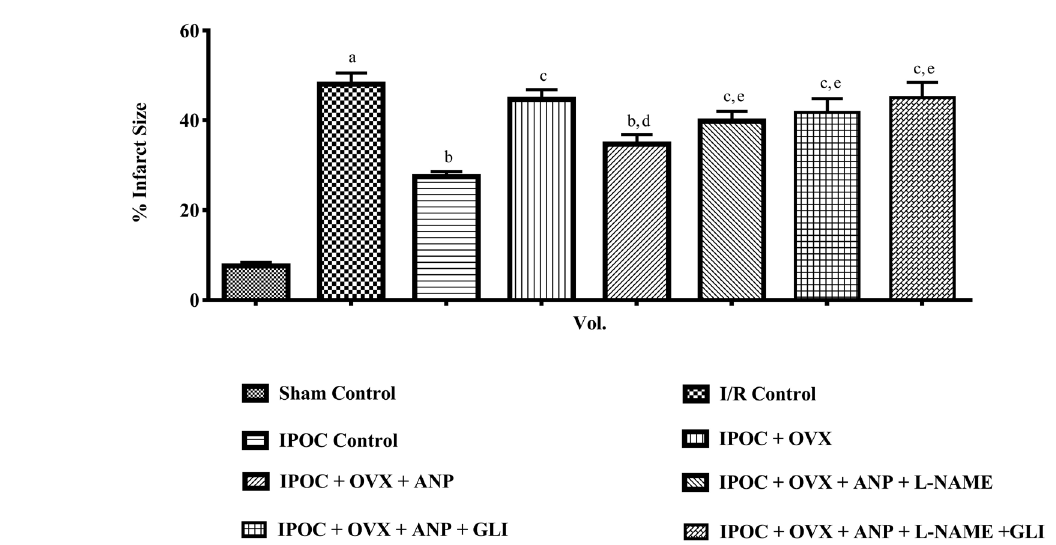
FIGURE 6 - Effect of I/R on myocardial infarct size, effect of IPTC on myocardial infarct size in normal and OVX rat heart, effect of ANP perfusion, effect of L-NAME and ANP perfusion, effect of Glibenclamide and ANP perfusion and effect of L-NAME, Glibenclamide and ANP perfusion on myocardial infarct size in heart of OVX rat. I/R denotes ischemic reperfusion; IPTC denotes ischemic postconditioning; OVX denotes ovariectomy; ANP denotes atrial natriuretic peptide; L-NAME denotes N- nitro L-arginine methyl ester. Values are expressed as mean ±S.D, a = p<0.05 vs. sham control; b = p<0.05 vs. I/R control; c =p<0.05 vs. IPTC in normal rat heart; d = p<0.05 vs. IPTC in OVX rat heart; e = p<0.05vs. IPTC in OVX rat heart with perfusion of